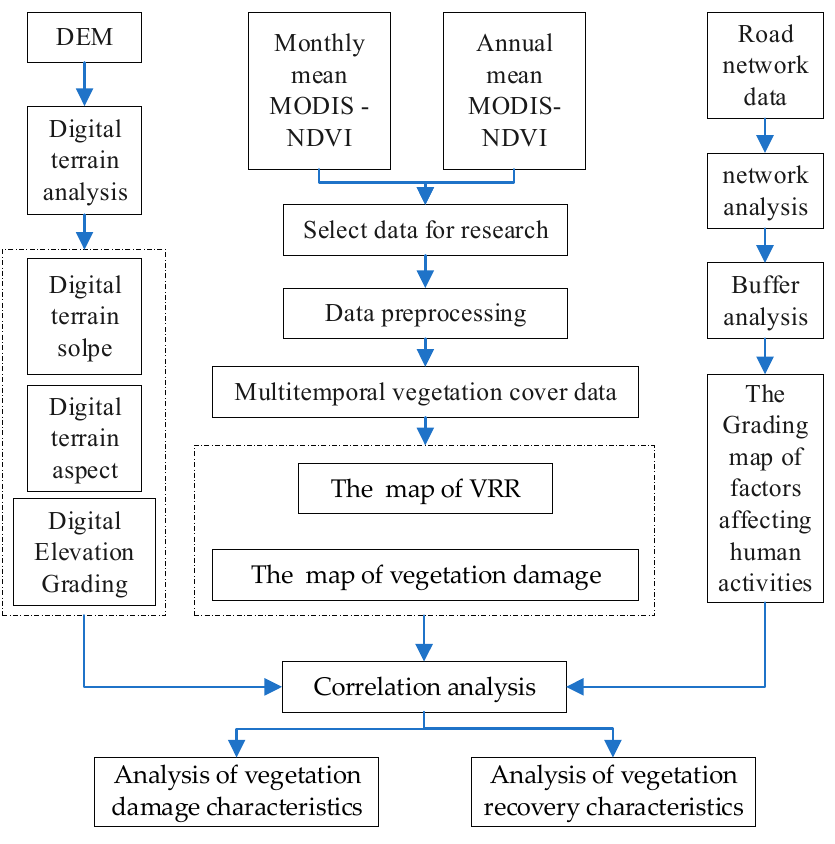
Figure 2. The flowchart of